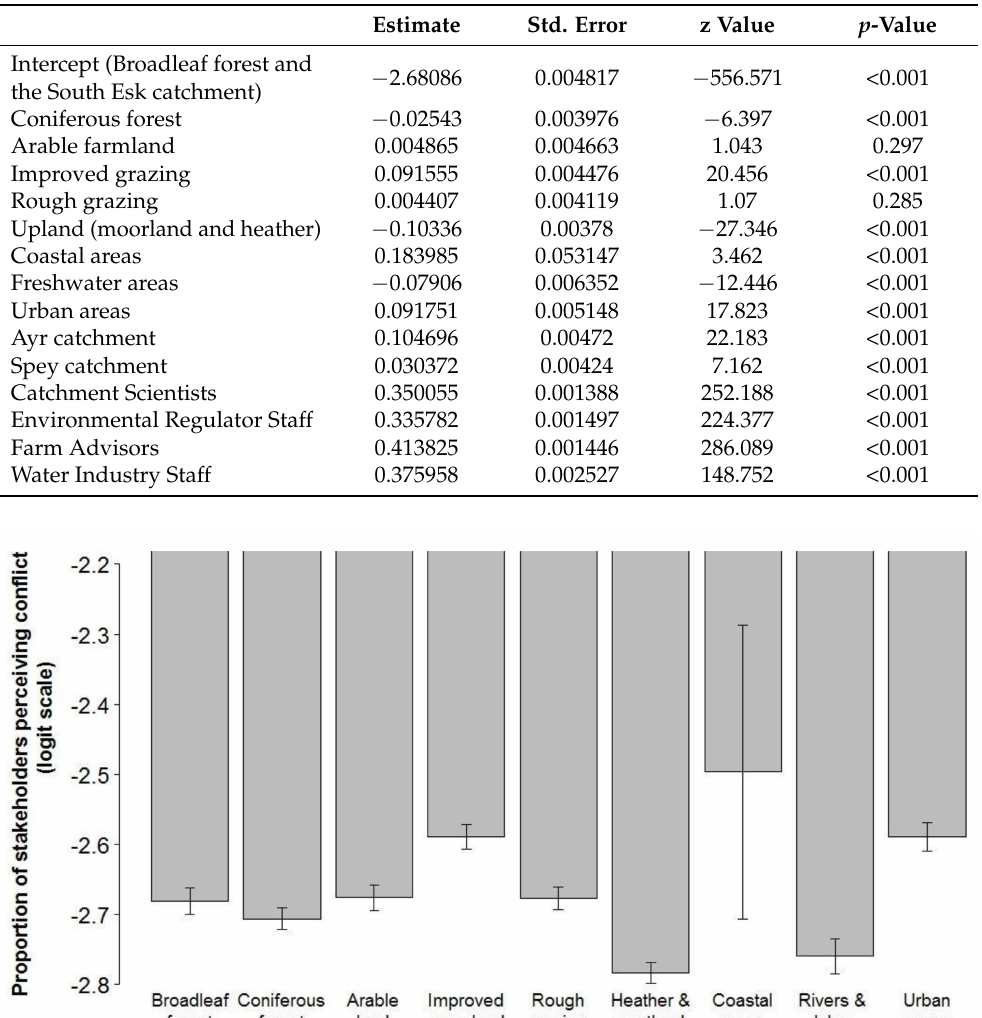
Table 2. GLM binomial modelling outputs of how the proportion of perceived conflict may be explained by land cover type, catchment, or stakeholder group.